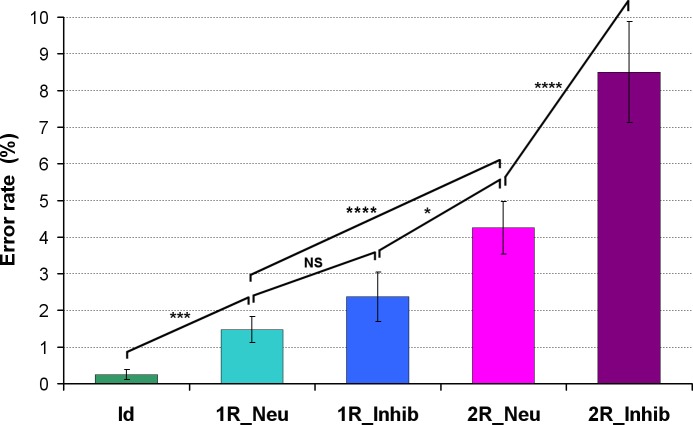
Result of the ER in 34 adult healthy controls (*:p<0.05, ***:p<0.005, ****:p<0.001, NS: Non Significant).